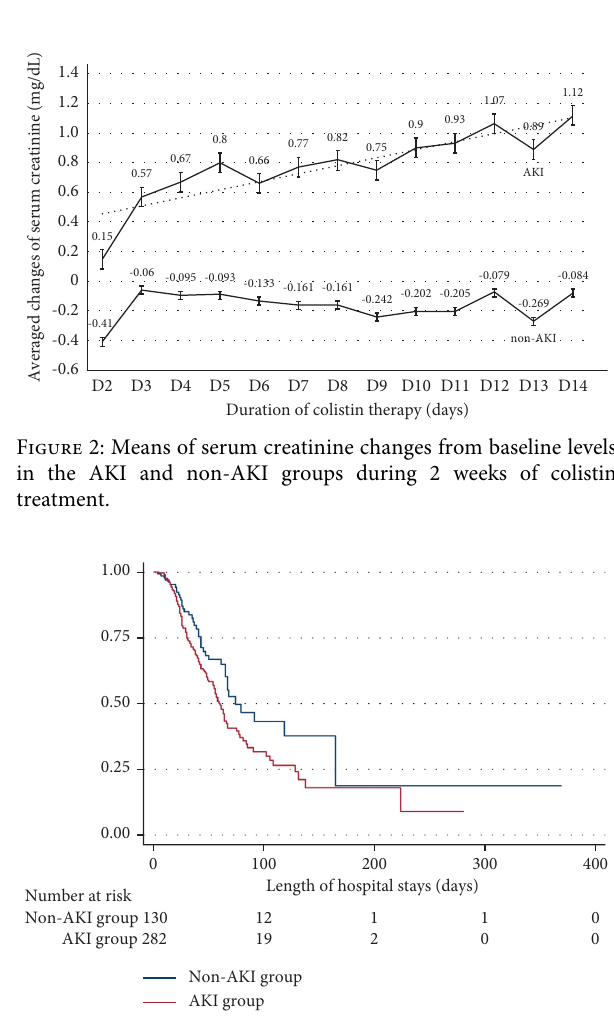
Figure 3: Kaplan–Meier curves of patient survival analysis com- pared between the colistin-induced AKI and non-AKI groups.